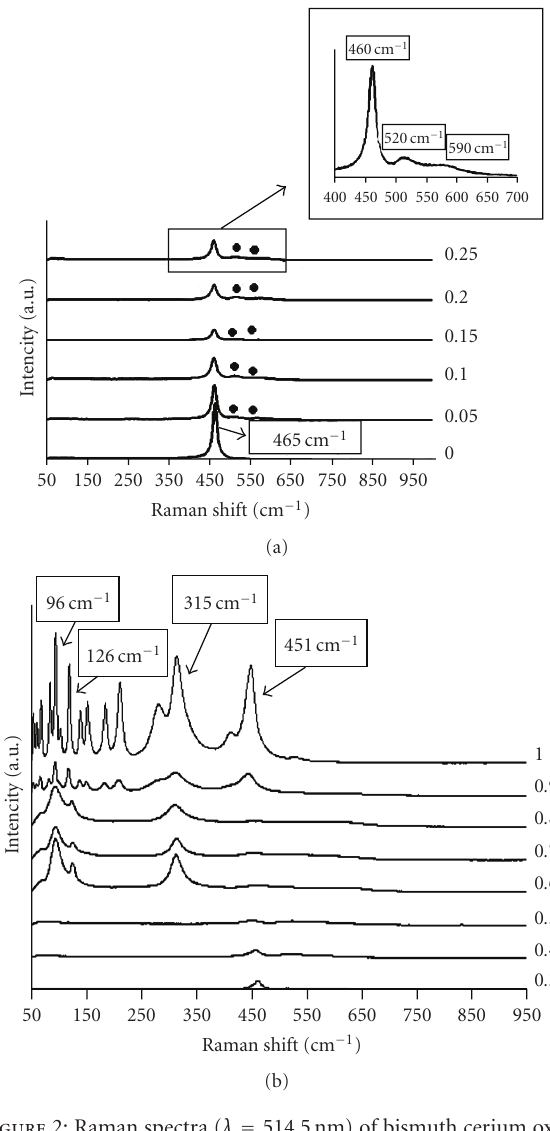
Figure 2: Raman spectra ( λ = 514 . 5nm) of bismuth cerium oxide phases, (1 − x ) CeO 2 , x /2. Bi 2 O 3 ; (a) solid solution for x = 0 to 0.25; (b) multiphase system for x = 0 . 30 to 1. Raman shift island are in cm − 1 , x values from 0 to 1. The bands at 520 and 590 cm − 1 are linked to structural